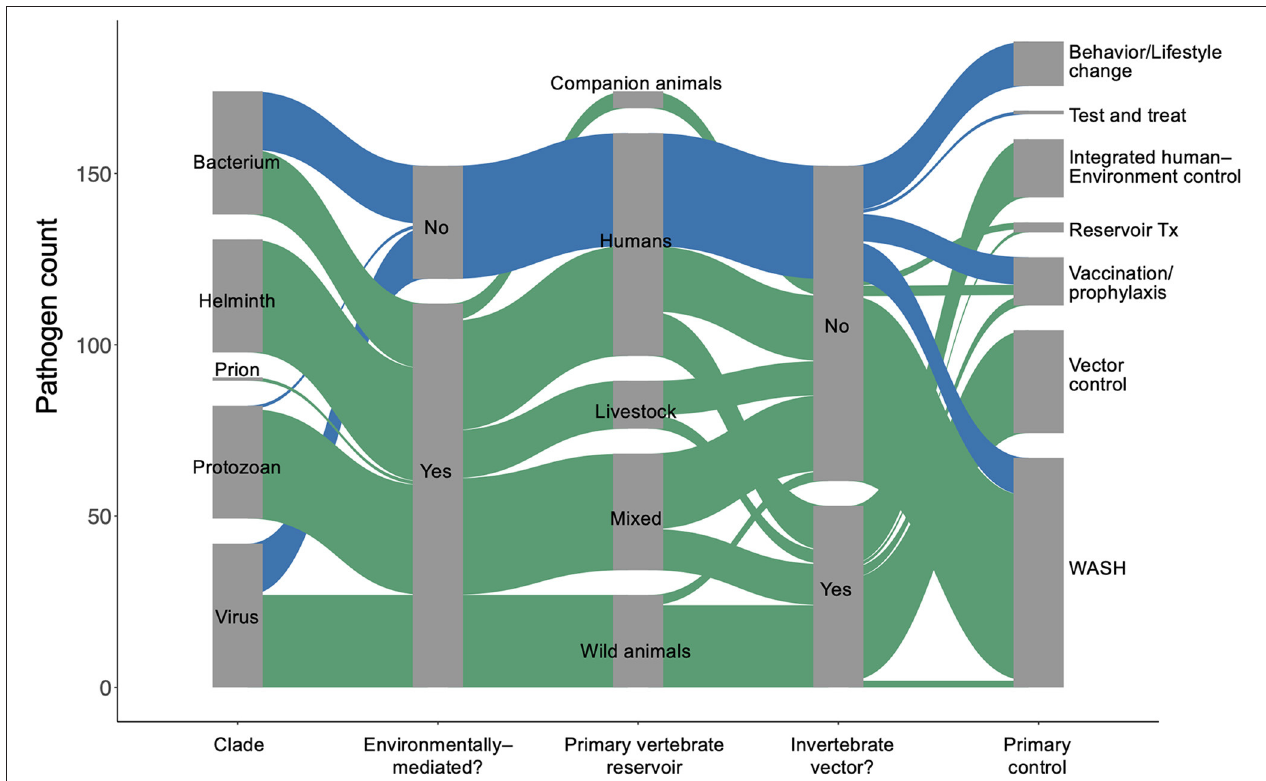
FIGURE 1 | An overview of the 150 most burdensome parasites and pathogens that infect